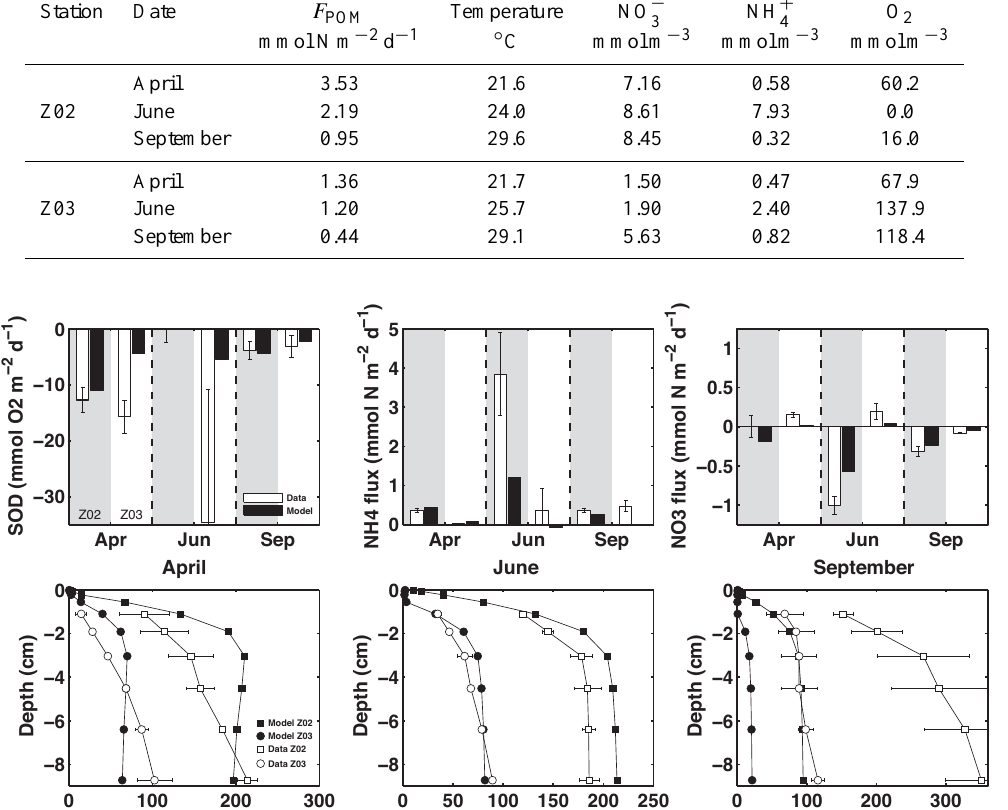
profiles (bottom row) for sites Z02 and Z03. Simulations 4